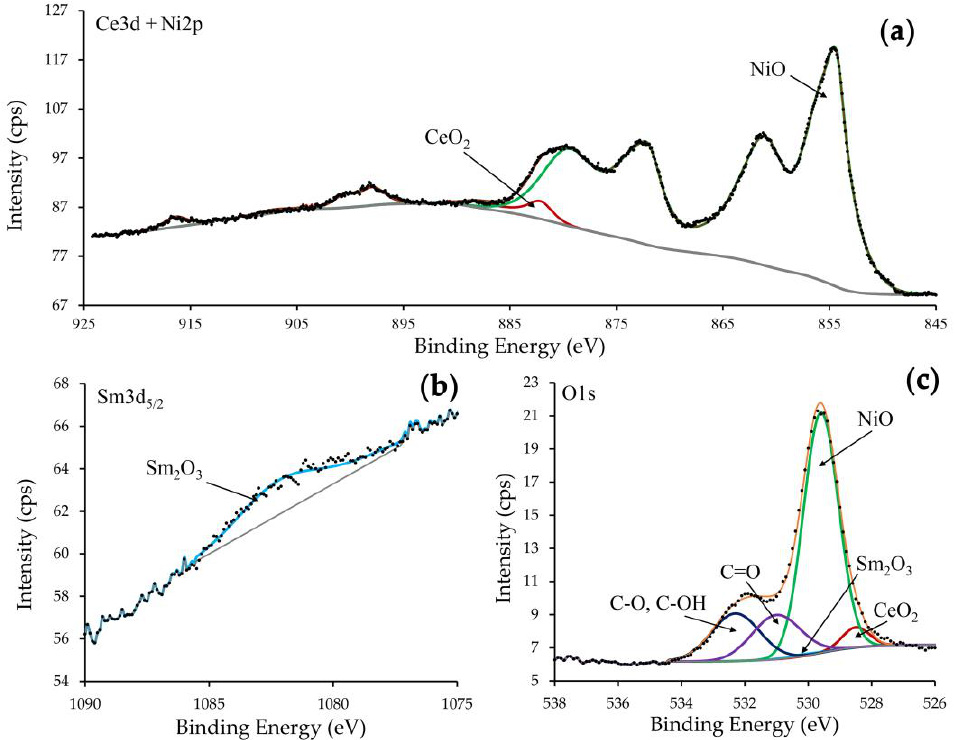
Figure 7. High-resolution (Ce3d + Ni2p) ( a ), Sm3d 5/2 ( b ), and O1s ( c ) XPS spectra of the printed ((CeO 2 ) 0.8 (Sm 2 O 3 ) 0.2 )@NiO composite anode film. ((CeO 2 ) 0.8 (Sm 2 O 3 ) 0.2 )@NiO composite anode film.